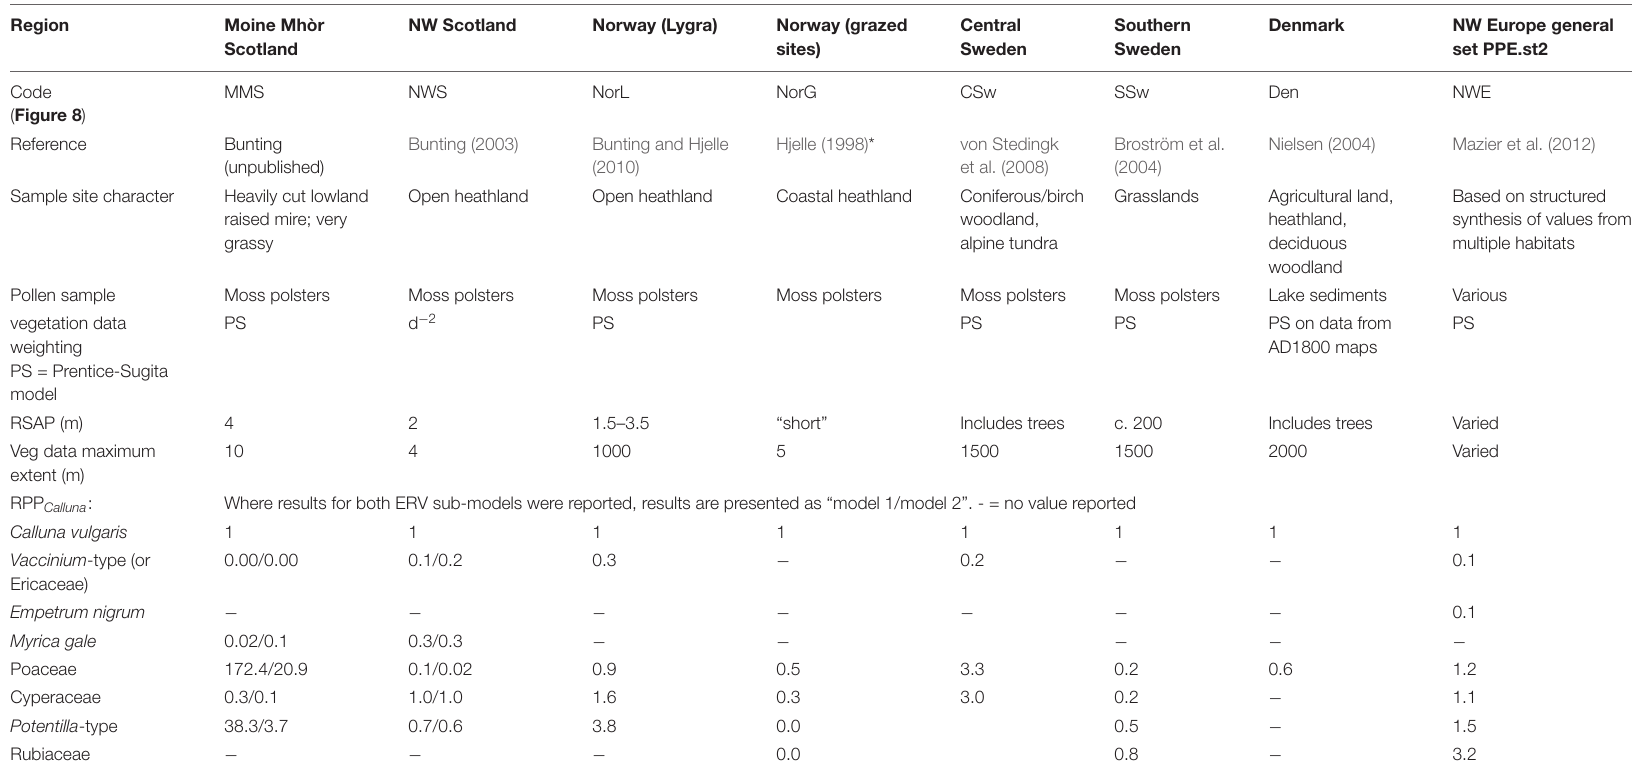
TABLE 1 | Comparison of Relevant Source Area of Pollen and Relative Pollen Productivity (reference taxon recalculated where necessary to Calluna vulgaris ) for other studies from heathland dominated landscapes.